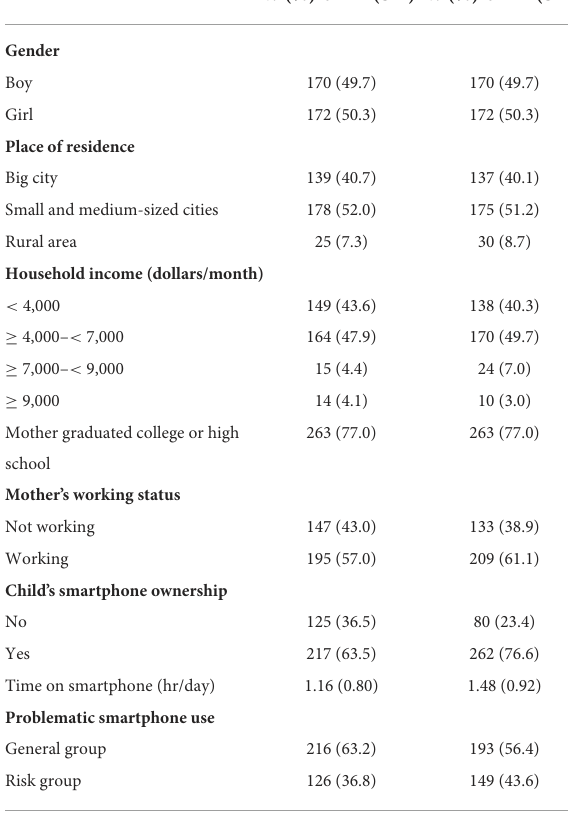
TABLE 1 Demographic and smartphone-related characteristics of wave 1 and wave 2 ( N = 342).